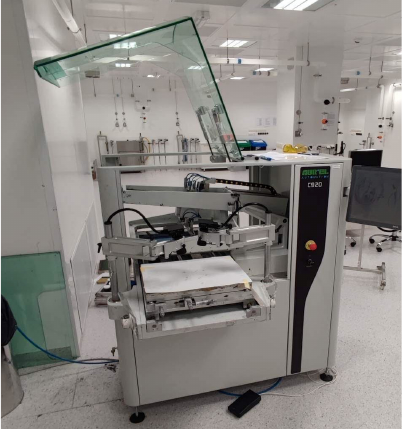
Figure 2. An Aurel c920 screen printer .